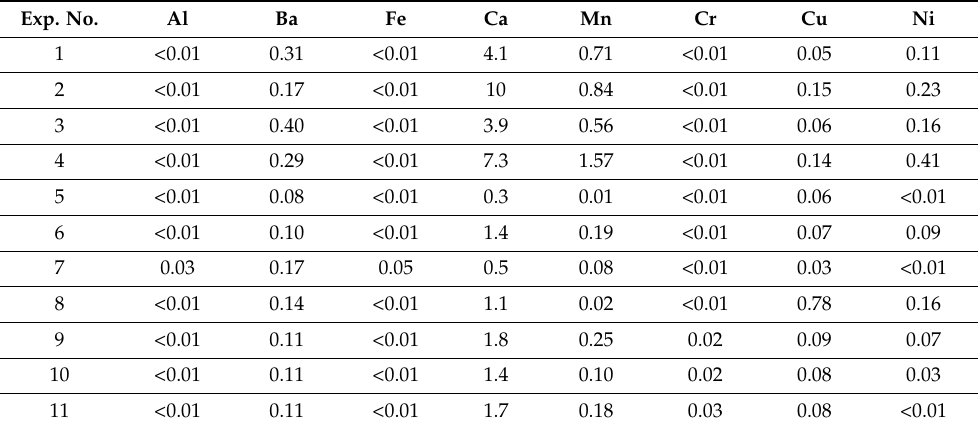
Table 3. Leaching of metals (%) from the mine tailing–sediment mixture calculated as the quantity of metals in the liquid phase compared to the total content of metals in mine tailings and liquid at the end of the leaching